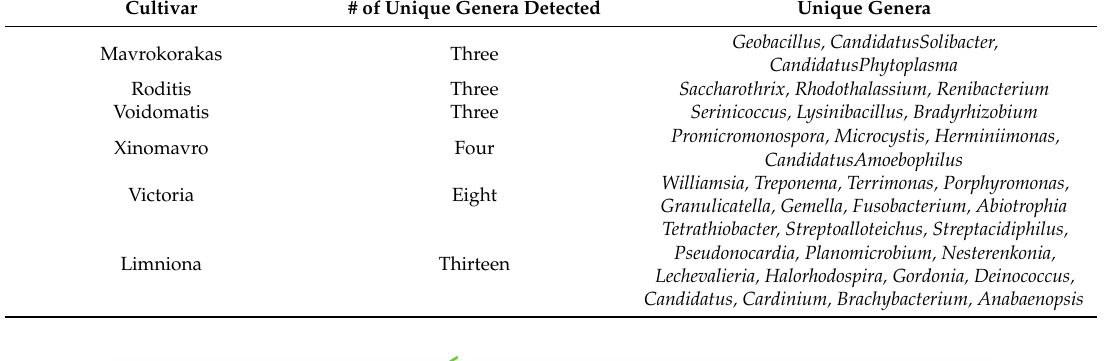
Figure 3. PCoA constructed using Bray-Curtis at the genus level for 37 grapevines. 9